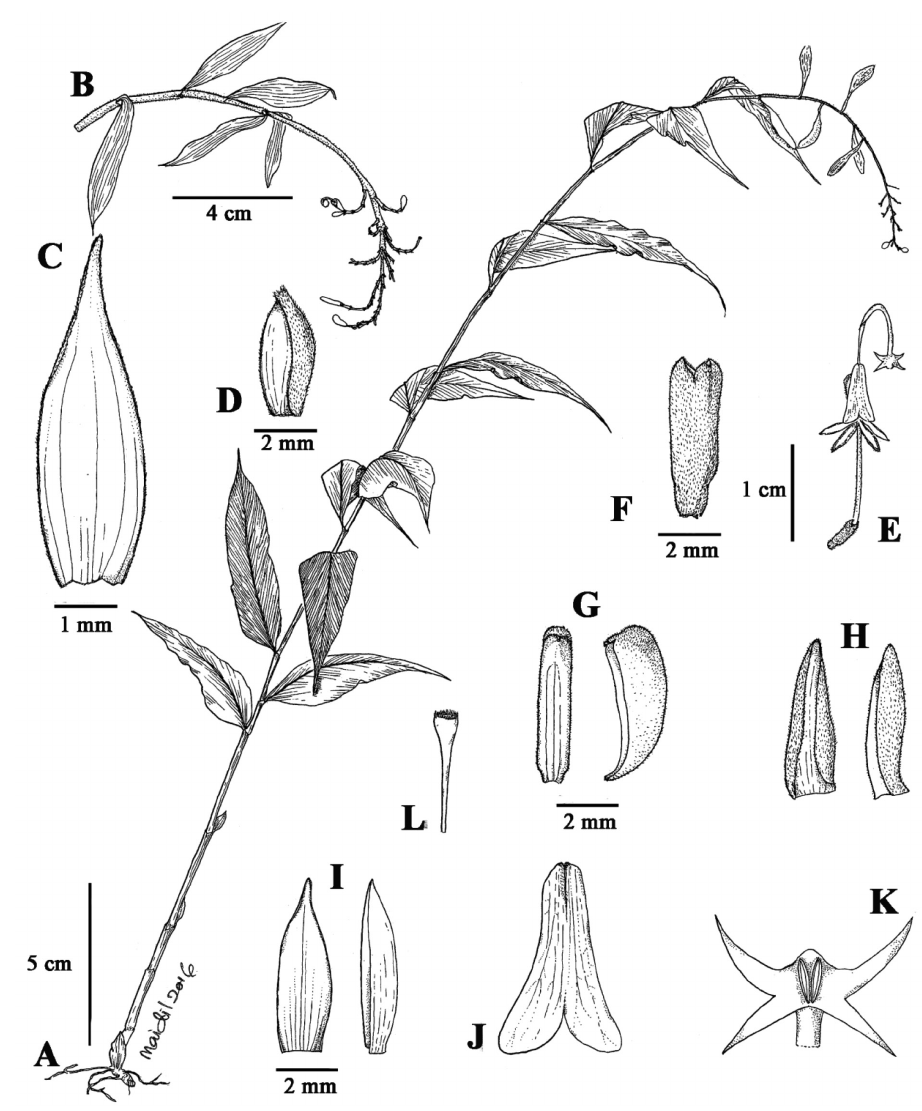
Figure 2. Globba magnibracteata Y.Y.Sam A Habit B Inflorescence C Sterile bract D Bracteole E Flower F Ovary and calyx G Dorsal corolla lobe in front and side view H Lateral corolla lobe in ventral and side view I Lateral staminodes in ventral and side view J Labellum K Anther appendages L Stigma. Drawn by M.N. Aidil from Sam & Aidil FRI 68959